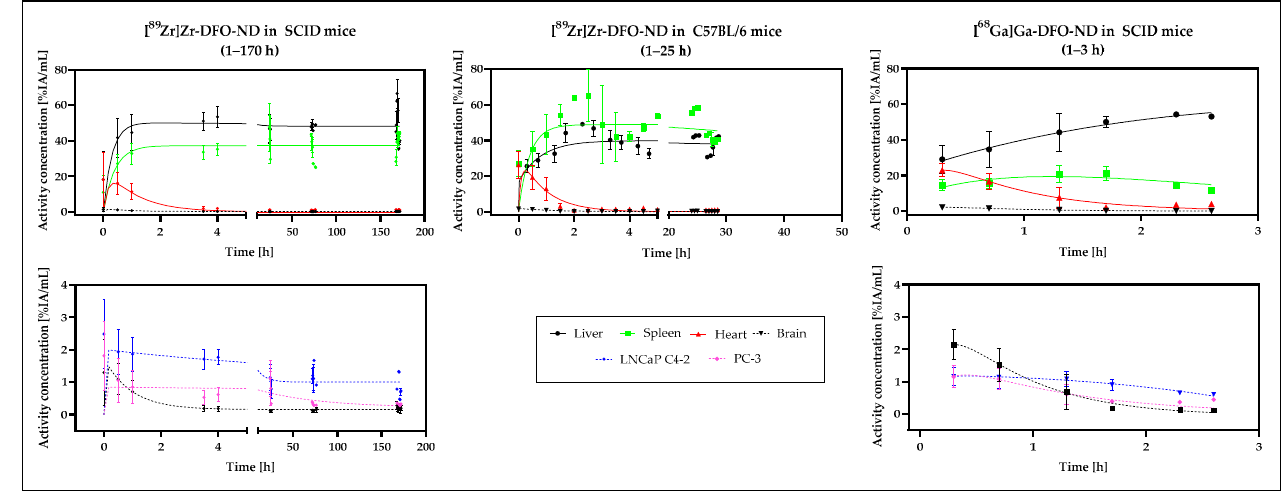
Figure 7. Time-activity curves (TACs) based on PET datasets were fitted using a three-exponential model in GraphPad Prism 9.4.0. TACs of liver, spleen, heart, and brain for the respective model ( 89 Zr- and 68 Ga-labeled NDs in SCID mice and 89 Zr-labeled NDs in C57BL/6 mice, respectively) were visualized in the top row. In the bottom row, the TACs for the tumors (LNCaP C4-2 and PC-3) in the SCID mice were also presented, along with the brain data.